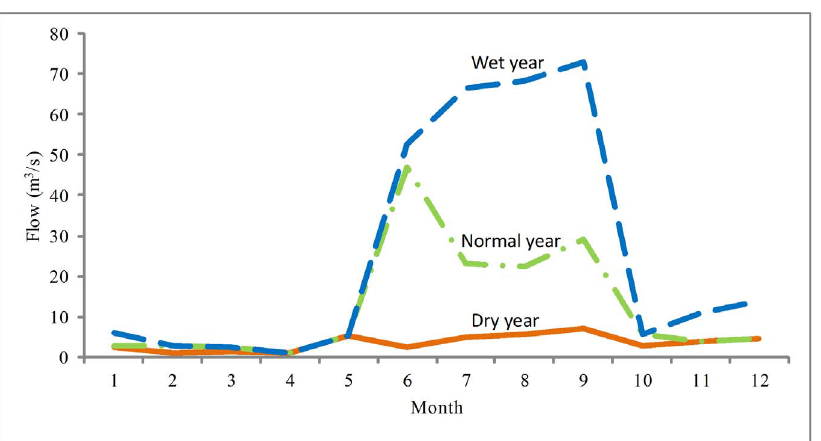
Figure 11. Flow recommendations of the Baiyangdian wetland in different scenarios. Inflow recommendations of the upstream rivers into the Baiyangdian wetland are calculated for dry (75%), normal (50%), and wet (25%) years.